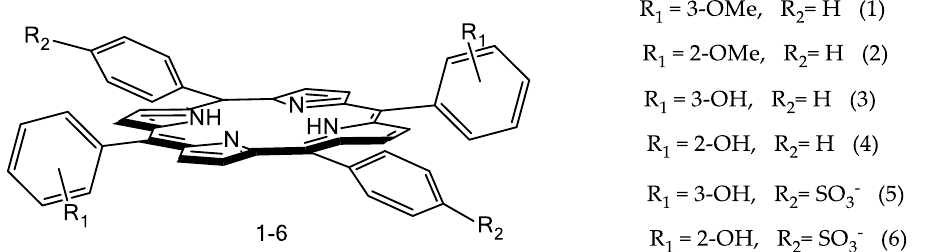
Figure 13. Structures of the porphyrins ( 1–6 ). Co(II)-5,15-bis-(hydroxyphenyl)-10,20-bis-(4-sulfophenyl)porphyrins [Co(II)P1, Co(II)P2] were obtained according to the literature procedure [56] from the corresponding porphyrin ligands ( 3 , 4 ) and Co(II) acetate by refluxing in DMF. Co(II)-5,15-bis-(3-hydroxyphenyl)- 10,20-bis-(4-sulfophenyl)porphyrin (Co(II)P1) . To 0.1 g (mmol) solution of compound 5 in 50 mL of dimethylformamide was added 100 mg of cobalt(II) acetate and resulting mixture was refluxed for 30 min. The resulting solution was diluted with water, the precipitate formed was filtered, dried, and chromatographed on aluminum oxide using toluene as an eluent. Yield of the Co(II)P1 was equal to 79%. Rf = 0.62 (aluminum oxide,